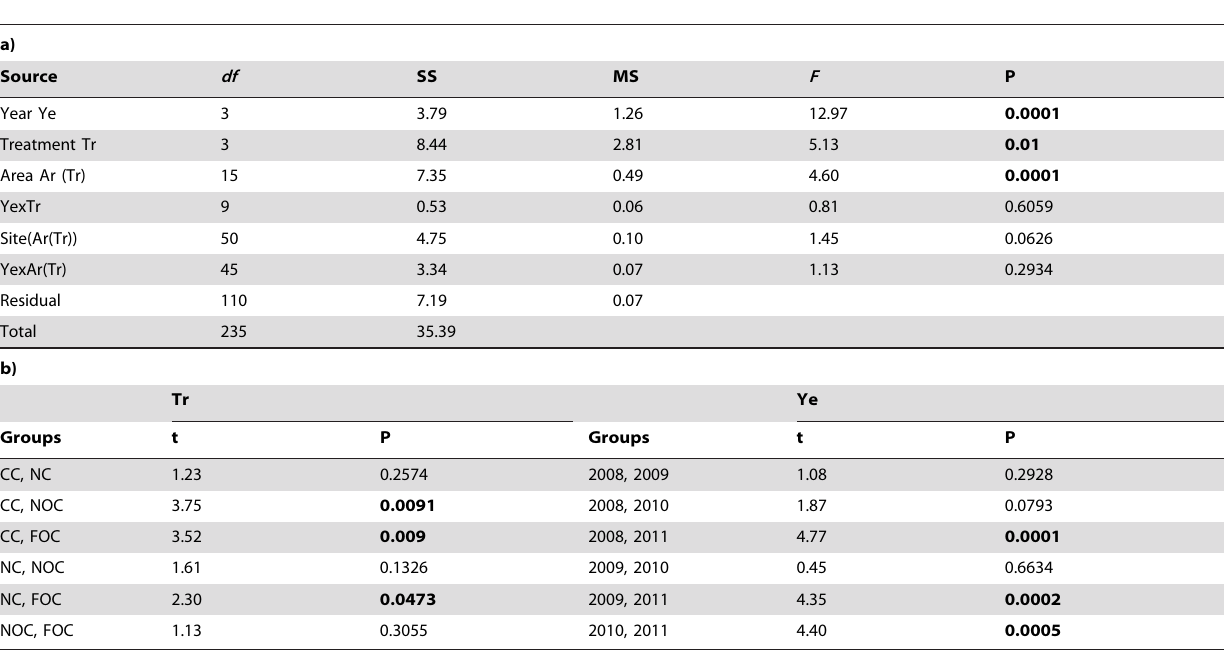
Table 2. PERMANOVA of abundance based on Euclidean distance measure.